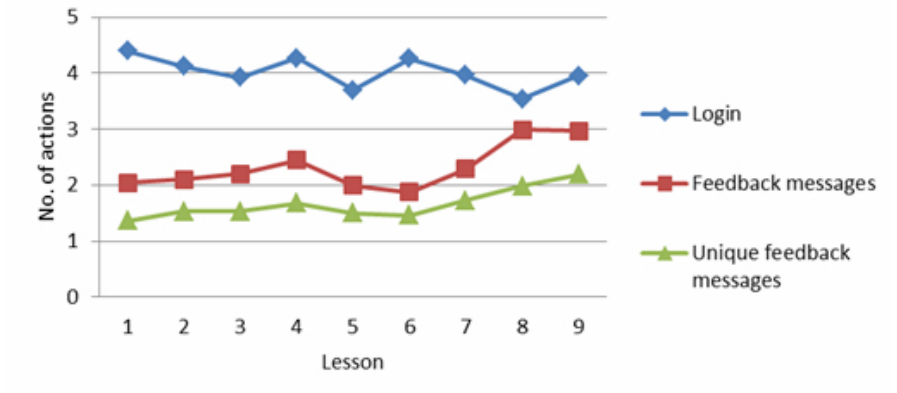
Figure 2. Login and feedback per lesson.